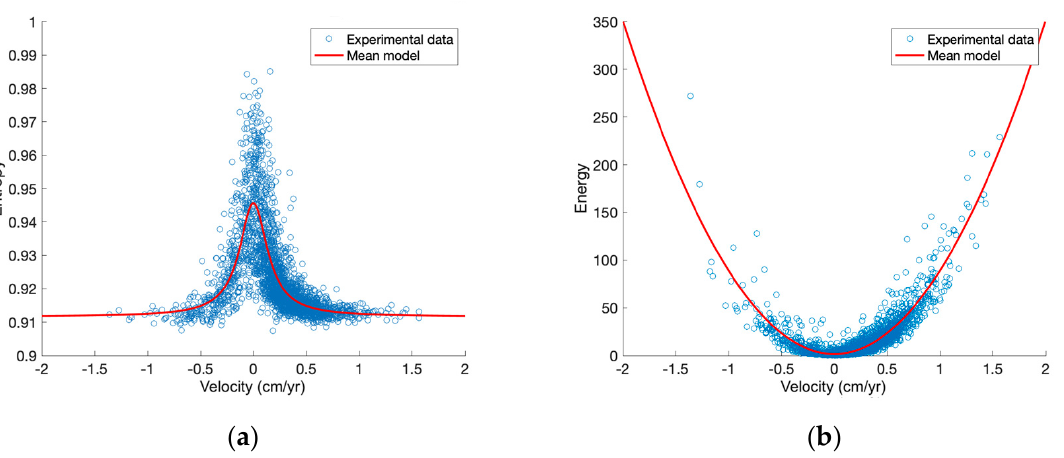
Figure 20. Correlation between LOS velocity and entropy–energy dispersion for the Colosseum in the period from 2015 to 2019: ( a ) Entropy–velocity dispersion; ( b ) Energy–velocity dispersion.